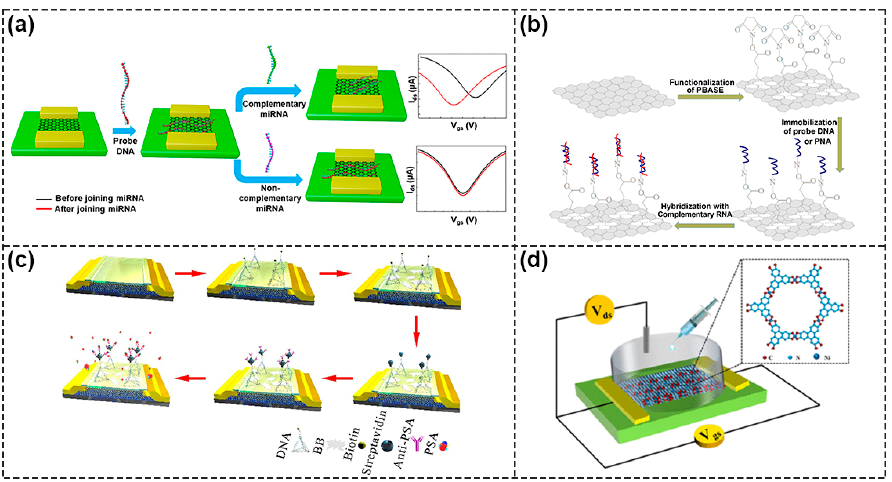
Figure 6. Representative FETs based on 2D materials. ( a ) Schematic of miRNA detection by GFET biosensors. Reproduced with permission from [50]. Copyright 2020, American Chemical Society. ( b ) Schematic of functionalization of PBASE as a linker on graphene surface. Reproduced with permis- sion from [51]. Copyright 2020 Elsevier B.V. ( c ) Schematic of MoS 2 FET with DNA functionalization. Reproduced with permission from [59]. Copyright 2021, Elsevier B.V. ( d ) Schematic of Ni–MOF–FET as biosensors for gluconic acid detection. Reproduced with permission from [65]. Copyright 2019, American Chemical